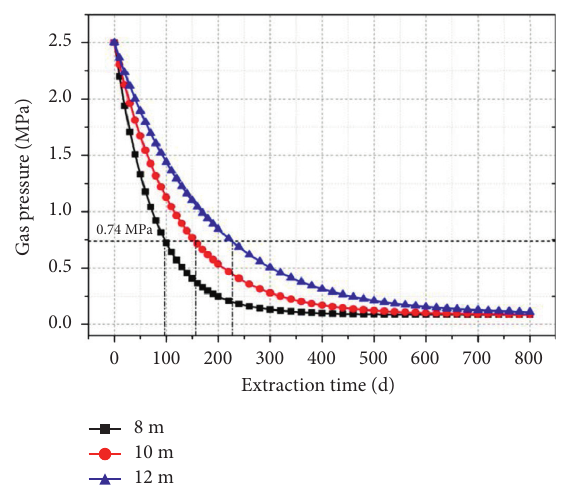
Figure 9: Variation of gas pressure at different spacing of